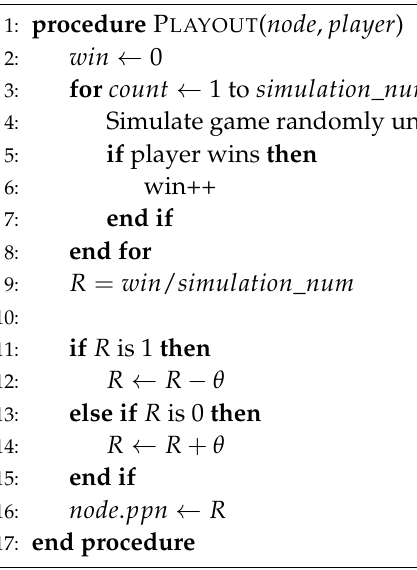
Algorithm 3 Playout algorithm